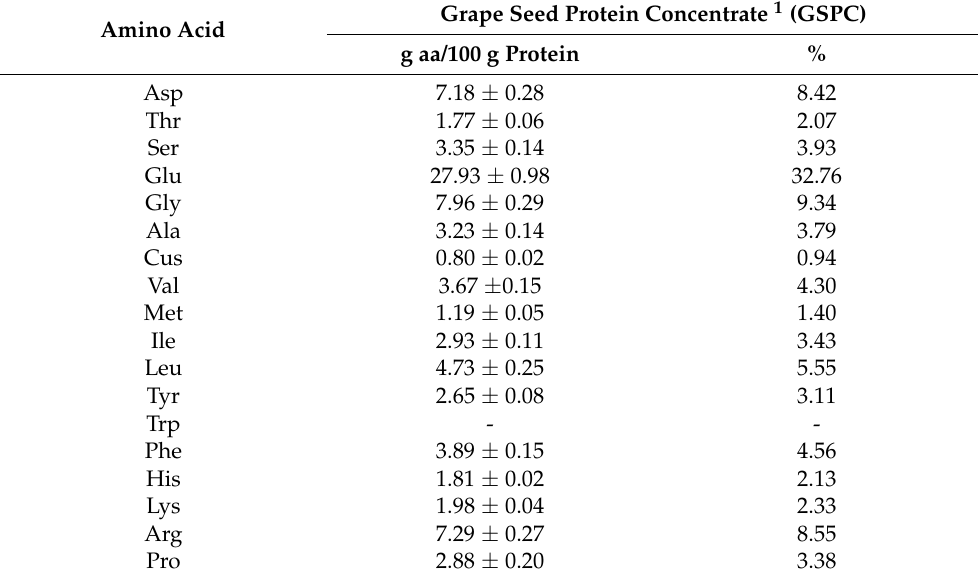
Table 4. The amino acid composition of grape seed protein concentrate (GSPC) (g aa/100 g protein and %). Amino